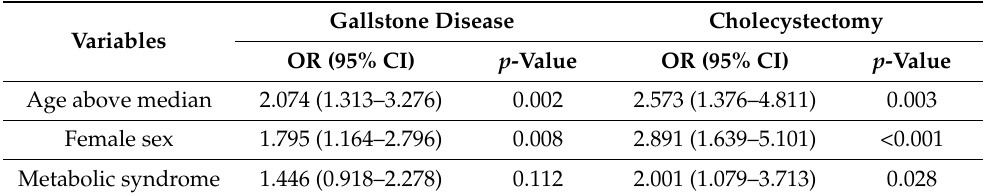
Table 3. Factors associated with gallstone disease and cholecystectomy al multiple logistic regres- sion analysis.